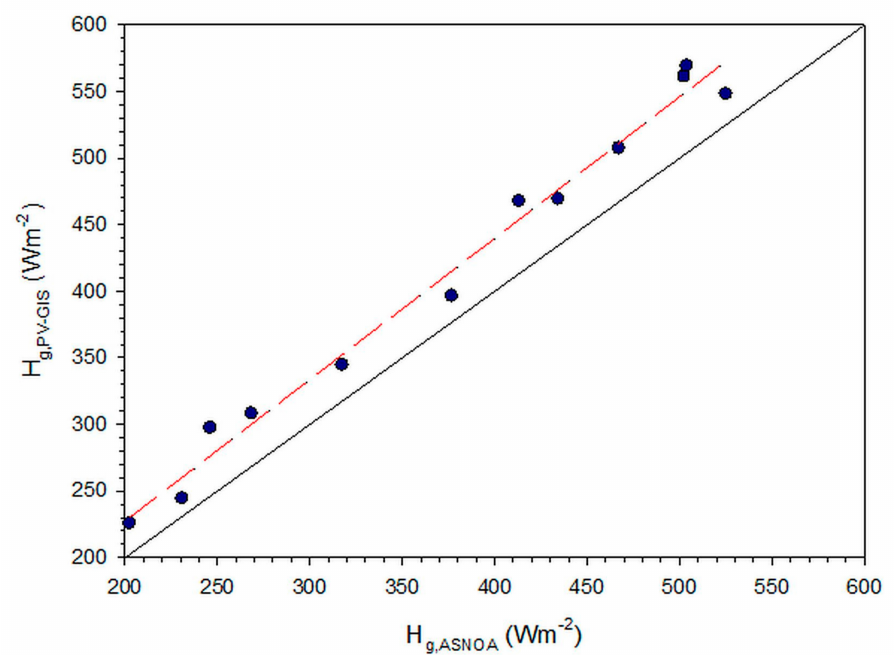
Figure 9. Comparison of monthly mean H g values from PV-GIS to measured H g values at ASNOA in the period 2005–2011. The red dashed line represents the best fit to the data points and is expressed by the regression equation: H g,PV-GIS = 1.06 H g,ASNOA + 14.96 (R 2 = 0.99). The solid black line is the 1:1 (or y = x) line. This figure is reproduction of Figure 8 in [1].